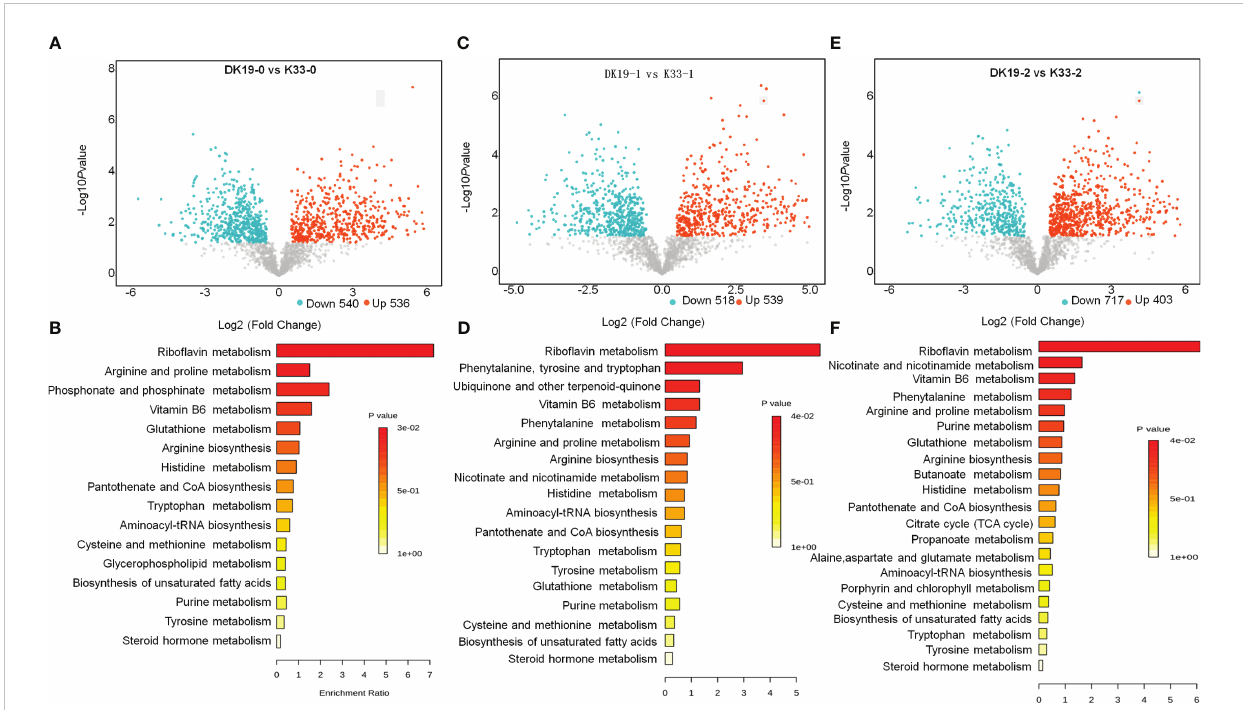
FIGURE 6 Screen of differentially accumulated metabolites (DAMs) at the same stages between DK19 and K33, generated using untargeted metabolomics sequencing. (A, C, E) Identi fi cation of differentially accumulated metabolites (DAMs) between DK19 and K33 at the control, 7days after the treatment and 17days after the treatment, generated using untargeted metabolomics sequencing technology. The volcano plot presents the expression of the DAMs in different treatments, the red dots represent up-regulated metabolites, and the blue dots represent down-regulated metabolites. (B, D, F) KEGG pathways of all DAMs between the DK19 and K33 at the same stages. The abscissa is the percent of differentially accumulated metabolites in different KEGG, and the ordinate is the type of KEGG enrichment. The darker the color, the higher the p